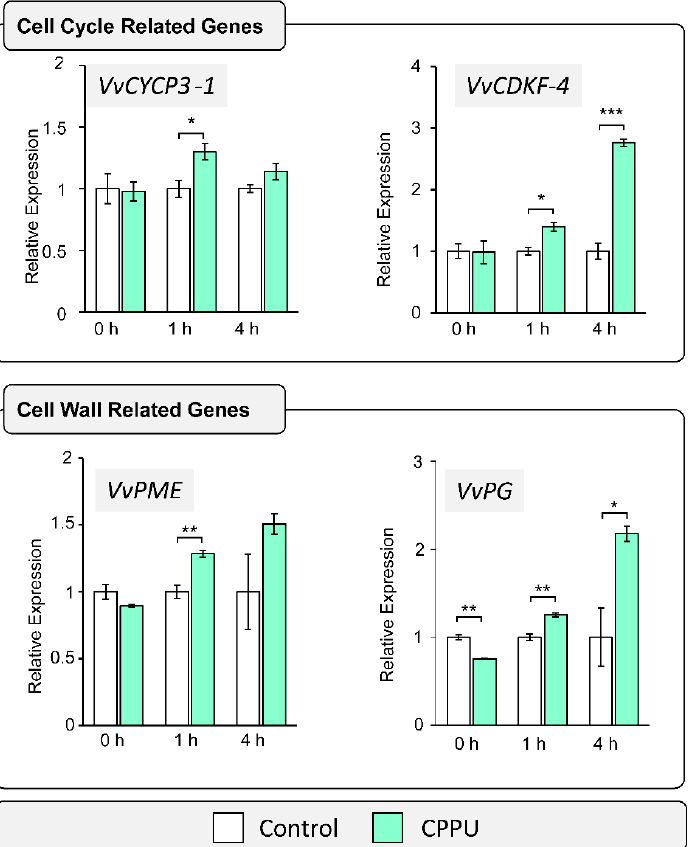
Figure 1. Early response of cell wall and cytokinin-related genes to CPPU treatment. Transcript